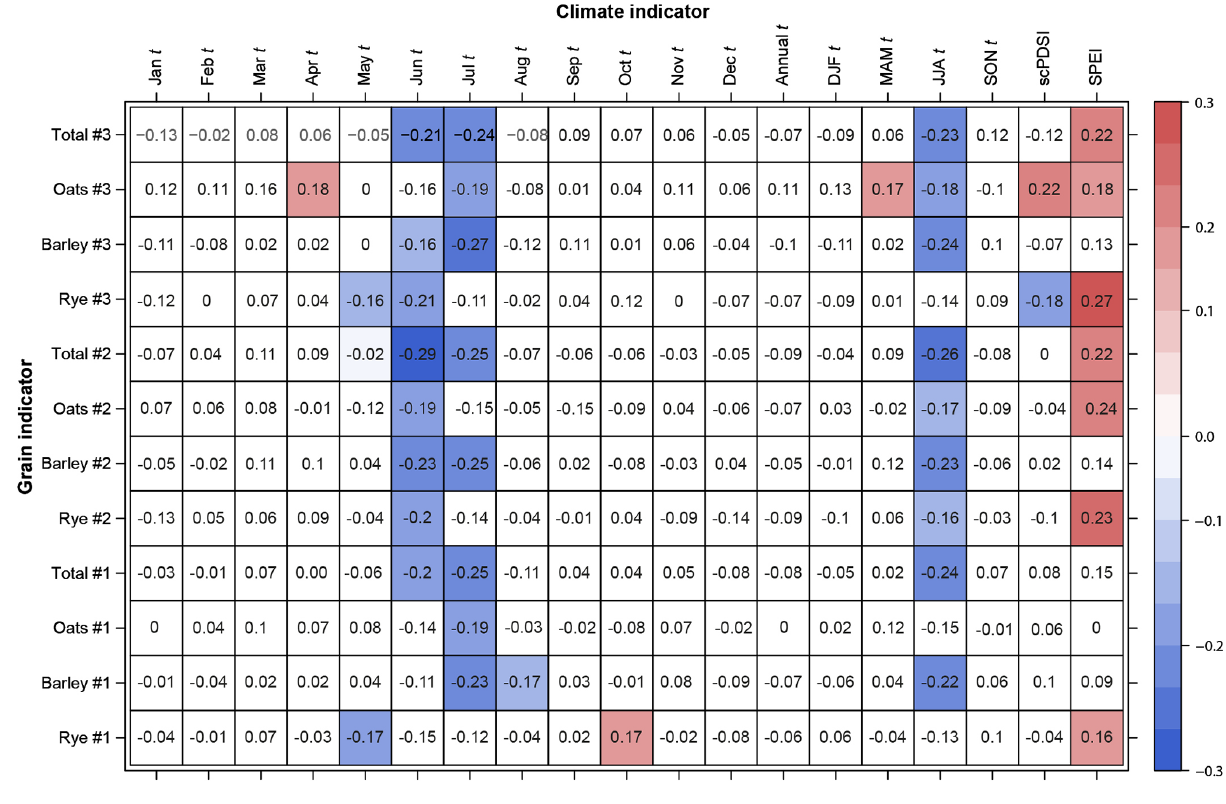
Figure 9. Correlations of grain series vs. temperature and hydroclimate indicators, ca. 1702–1865. Note: only statistically significant ( p ≤ 0 . 05) correlations are colored. Clusters are signified by number. Sources: HDSA, Cook et al. (2015), Seftigen et al. (2017), and the homogenized monthly temperature series (Appendix